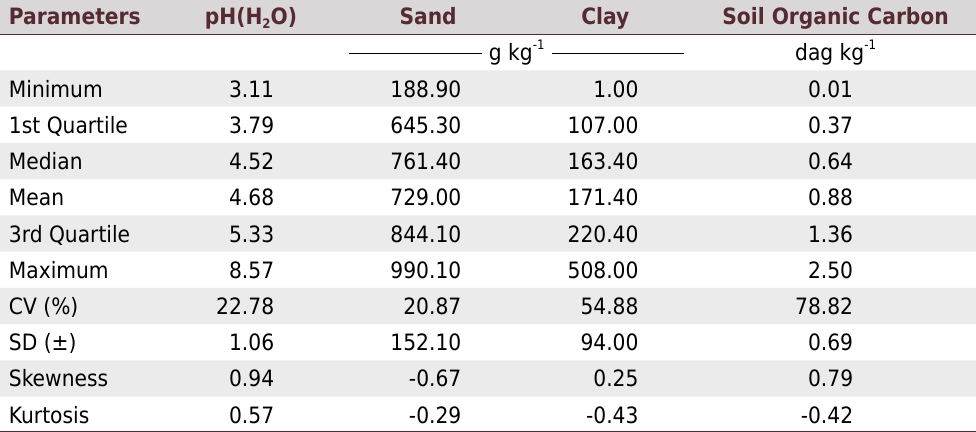
Table 2. Descriptive statistics of pH in water, sand, clay, and organic carbon contents in the Piauí State, Brazil